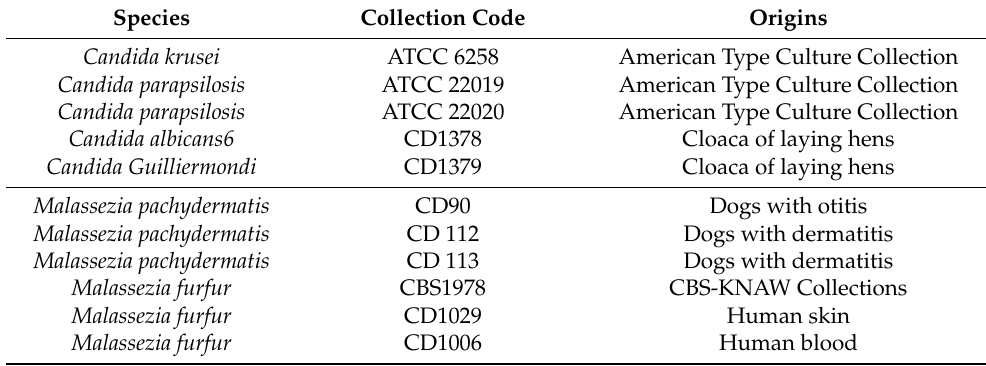
Table 1. The used yeast strains in the present